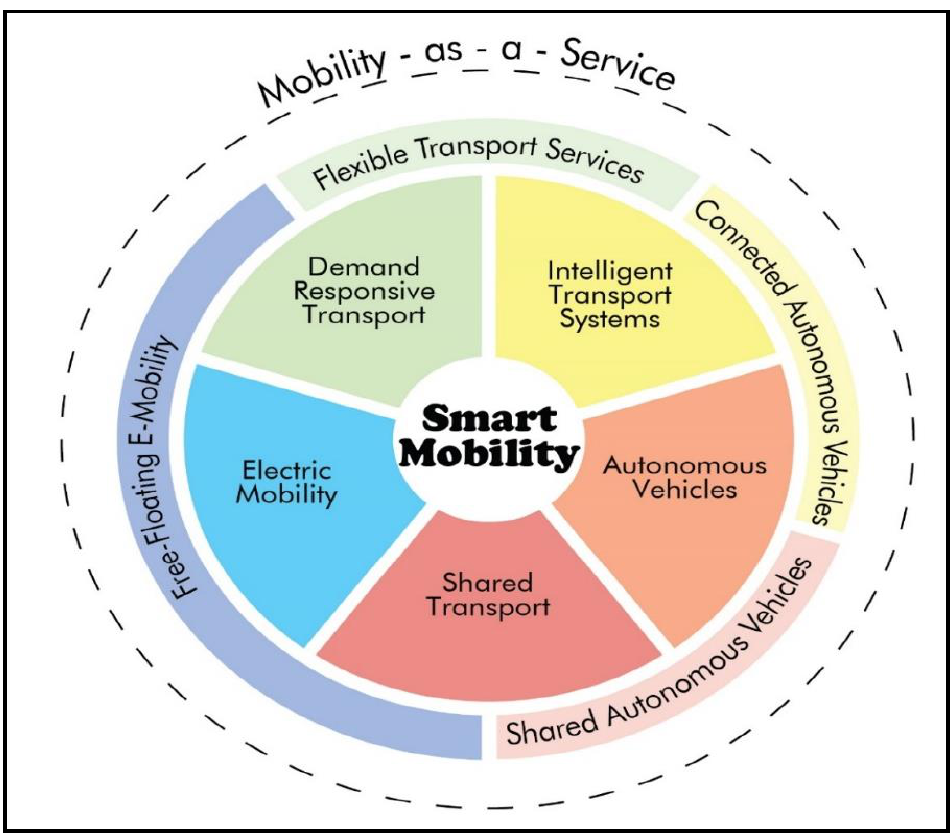
Figure 3. Relationship between smart mobility innovations (source: authors).